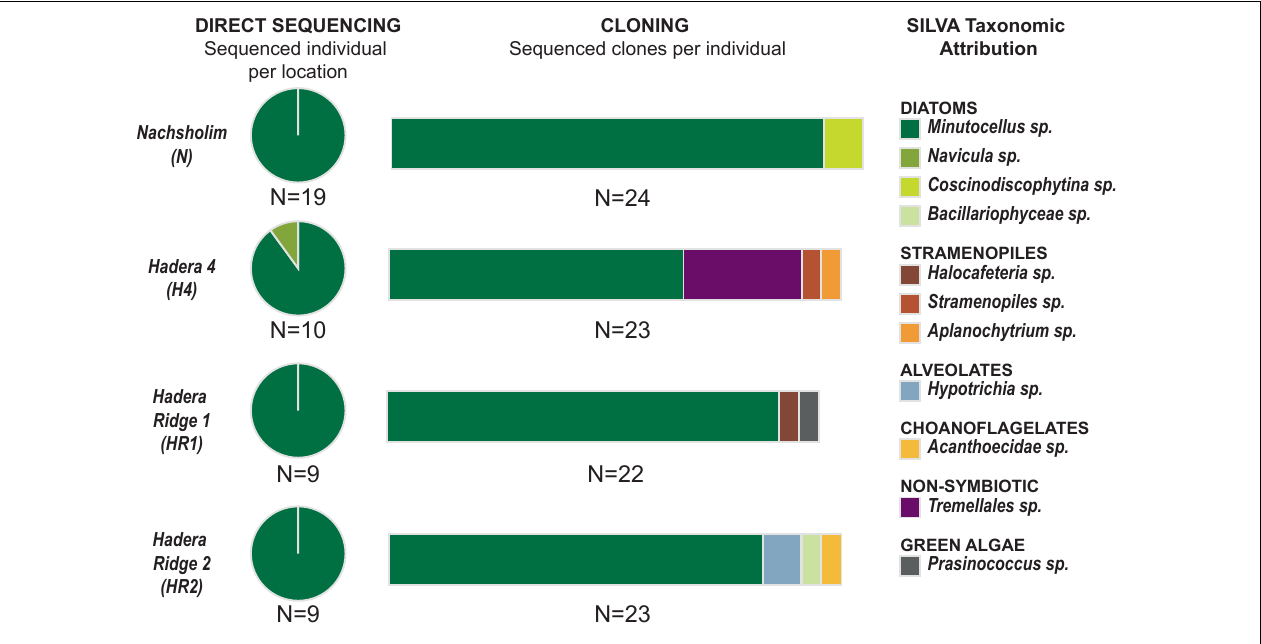
FIGURE 3 | Genetic Results. (Left) Indicates the results obtained with direct sequencing for each of the four locations. (Central) Indicates the results of cloning obtained for one selected individual for each location. (Right) Indicates the taxonomic assignation of the sequences using the SILVA database.